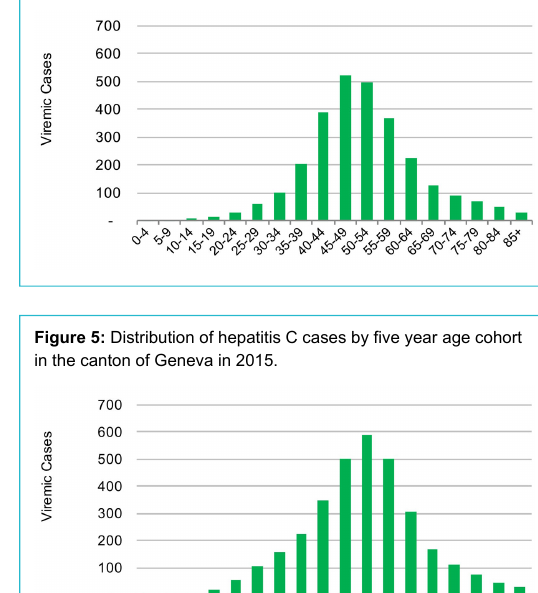
Figure 4: Distribution of hepatitis C cases by five year age cohort in the canton of St Gallen in 2015.